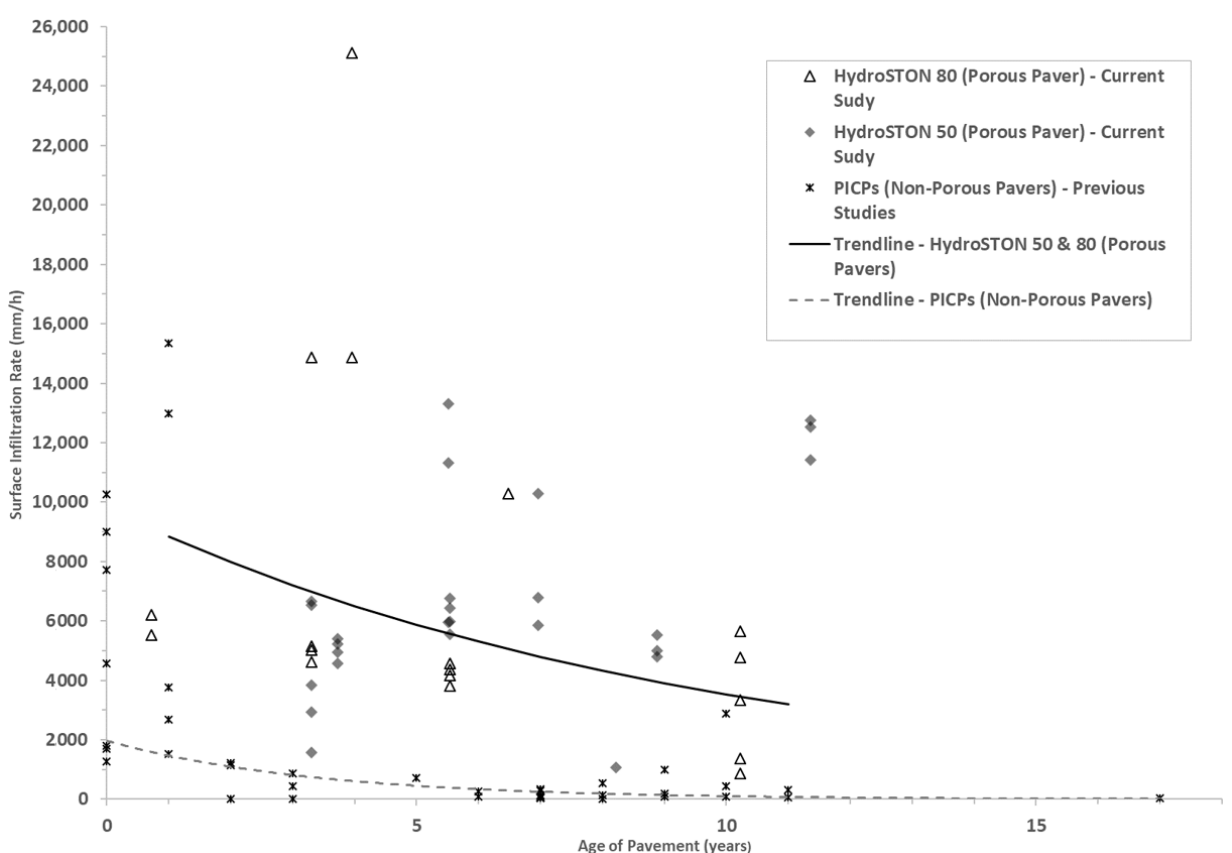
Figure 3. Infiltration rate versus the age of PICPs with both porous and non-porous pavers.